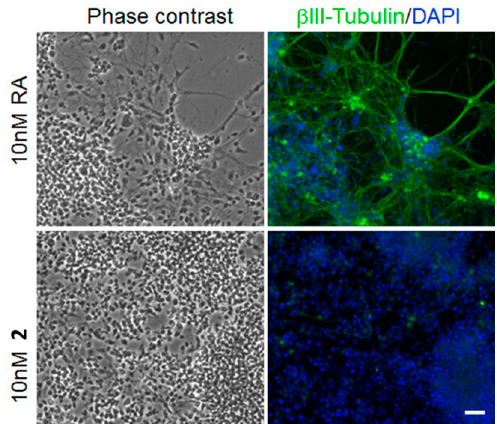
Figure 3. Upper row: NE-4C neural stem cells differentiate to neurons upon treatment with 10 nM of all- trans retinoic acid (RA). Bottom row: retinoate 2 (10 nM) did not elicit differentiation of NE-4C stem cells. Right column shows immunohistographs after staining for neuron specific ß-tubulin III (green) and for nuclei with DAPI (blue). Scale bar: 50 µm.